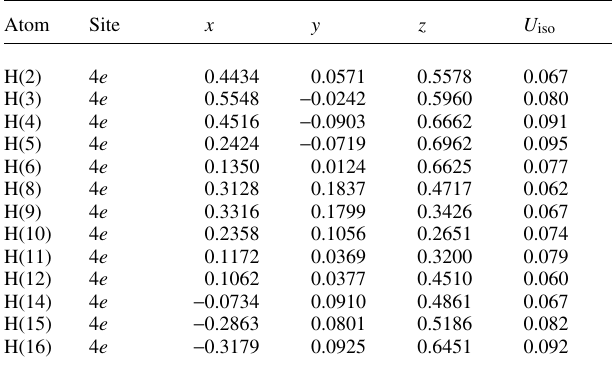
Table 2. Atomic coordinates and displacement parameters (in Å 2 )